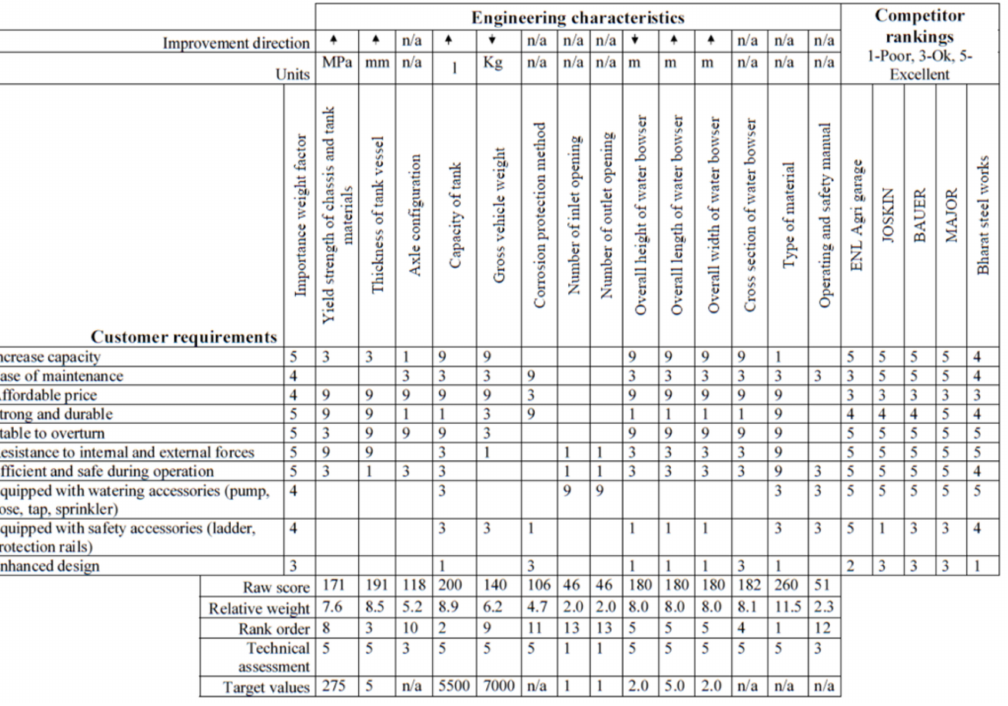
Figure 3. House of quality matrix (including